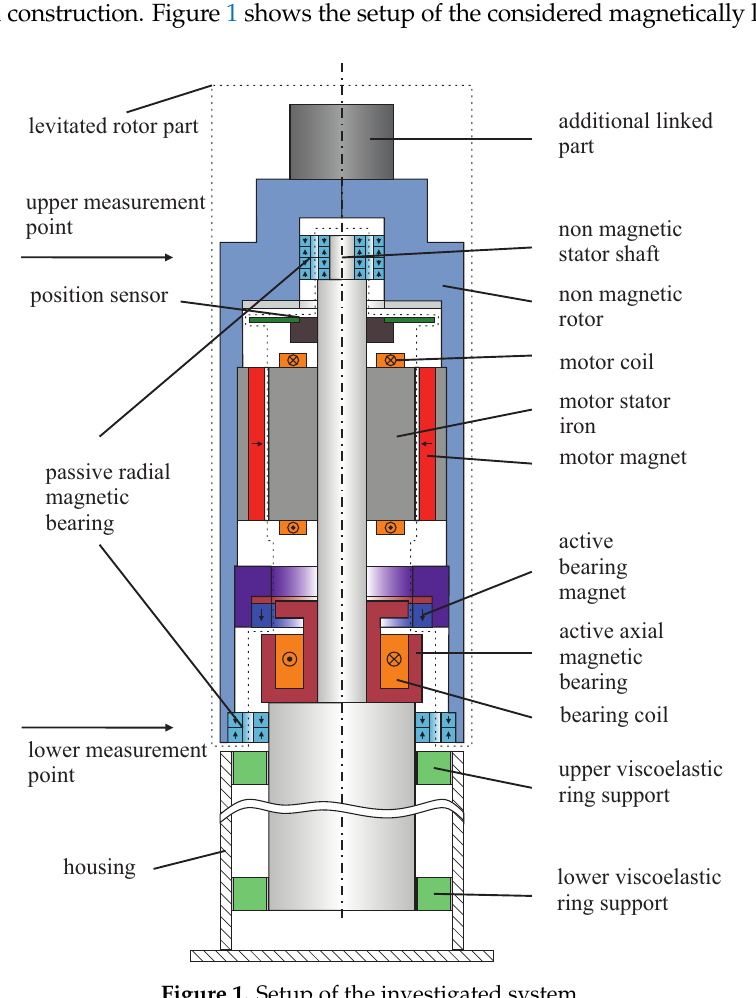
Figure 1. Setup of the investigated